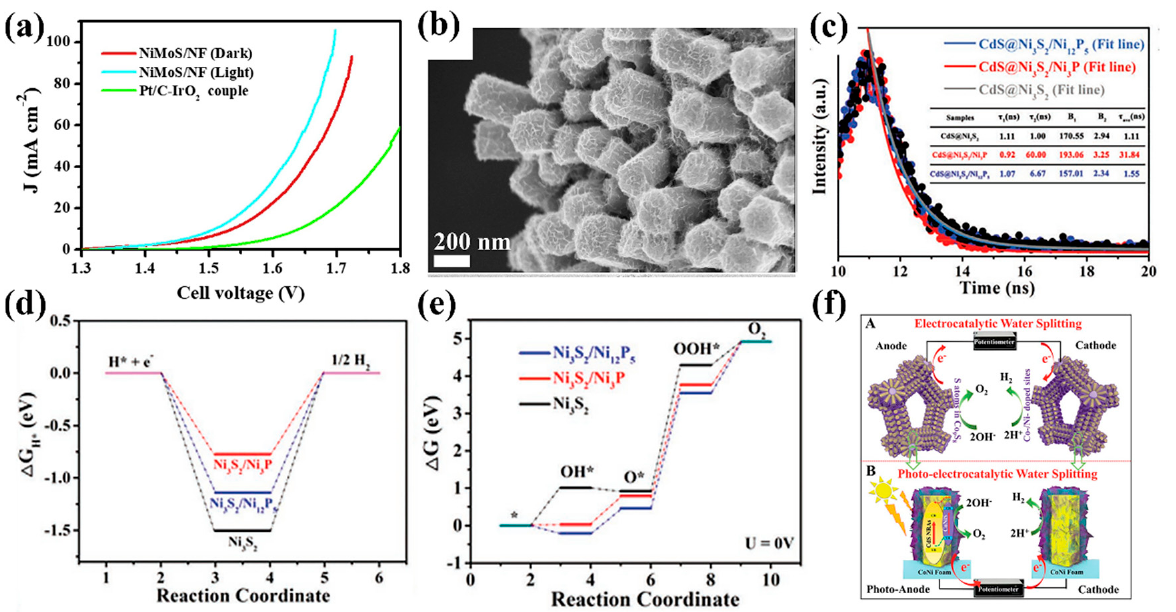
Figure 7. ( a ) Overall water splitting LSV curves of NiMoS in light and dark conditions.